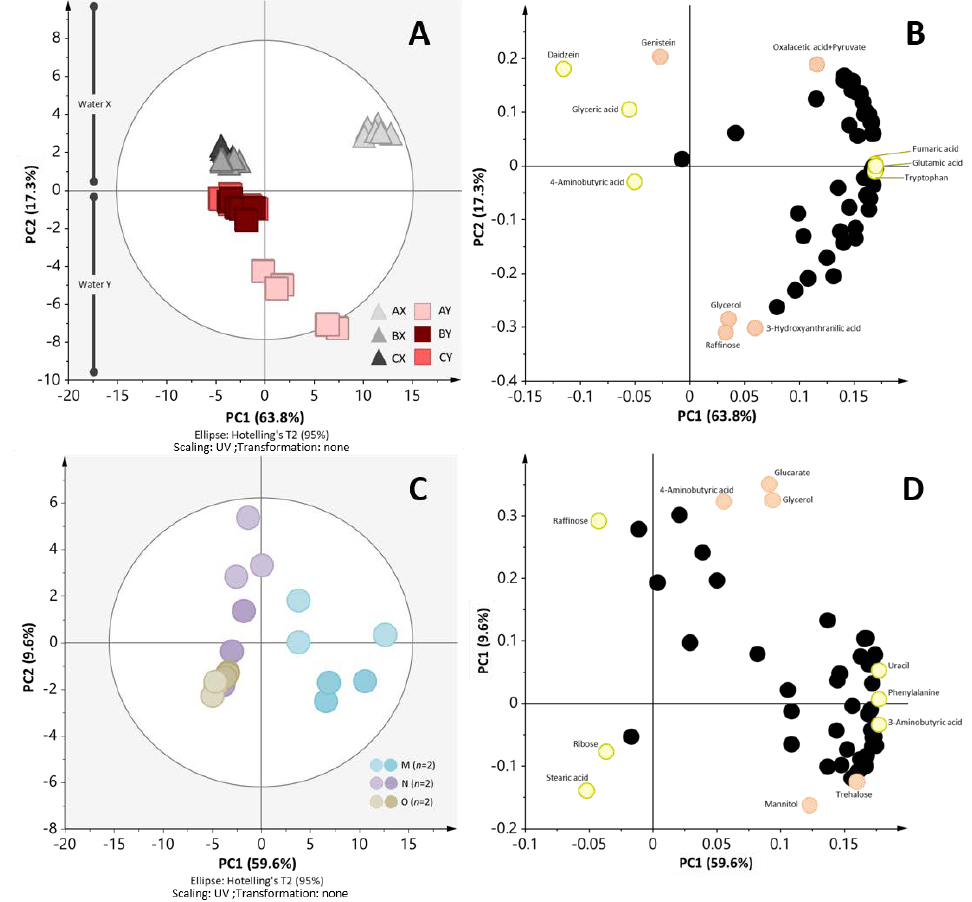
Figure 3. E ff ect of raw materials and starter culture on metabolite profiles of tempe. ( A ) PCA score scatter plot of tempe made with di ff erent water and soybean from 53 annotated metabolites. In this experiment three soybeans were used (A, B, and C; coded by color). In addition, two di ff erent water types were used (water X and Y; coded by triangle). In this plot, two biological replicates and three chemical replicates from each sample are presented. Here, it shows that tempe AX and AY are separated from tempe BX, BY, CX, and CY along PC1 (explains 63.8% of variance). Additionally, it is shown that tempe made by water X (triangle) and water Y (rectangular) separated from each other along PC2 (explains 17.3% of variance). ( B ) The PCA loading plot raw material experiment. Representative metabolites are notated in this plot (yellow = PC1; orange = PC2). ( C ) PCA score plot of starter culture set. This figure shows tempe M (blue) has a di ff erent metabolite profile to that of tempe N (purple) and O (green) based on PC1 which explains 59.6% of variance. ( D ) The PCA loading plot showing representative metabolites that contribute to separation (yellow = PC1; orange = PC2).